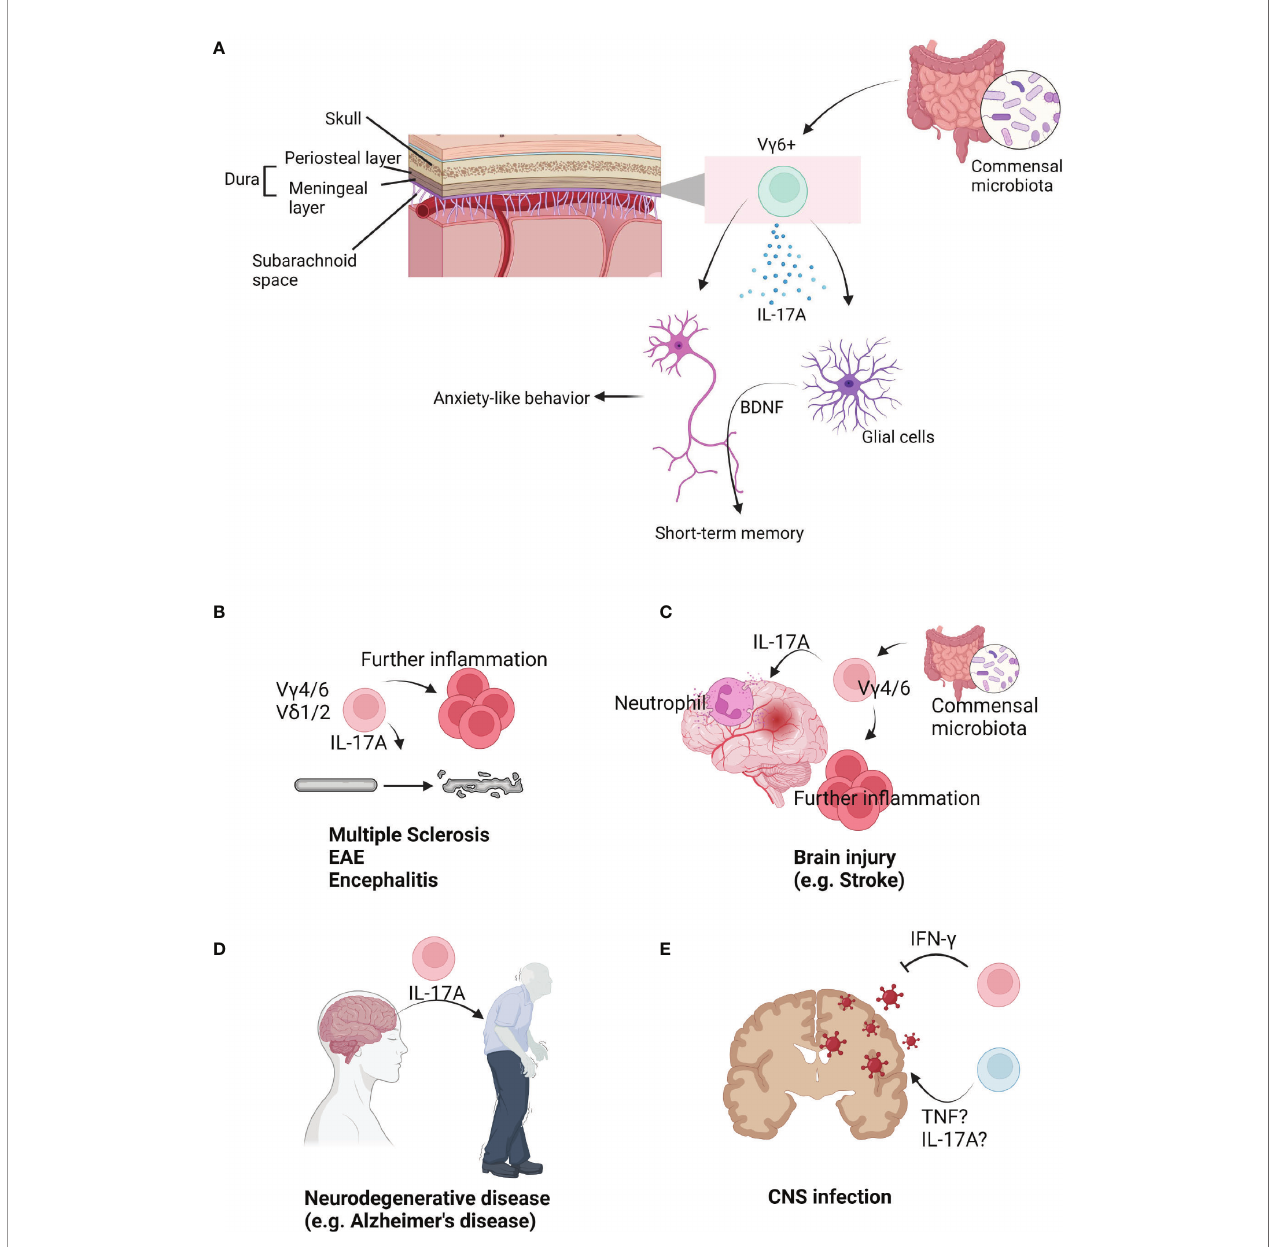
FIGURE 2 | The role of gd T cells in brain immunology. (A) Upon brain parenchyma, multiple layers surround brain. Under skull, dura mater (periosteal layer, meningeal layer) is situated. Under meningeal layer, arachnoid and subarachnoid space exist. In the meninges, V g 6+ cells are populated. They seem to be affected by commensal microbiota. Under steady state, V g 6+ cells produce IL-17A. IL-17A from meninges can be delivered into the parenchyma. Direct signal from IL-17A into neurons can regulate anxiety-like behavior. On the other hand, IL-17A can regulate short-term memory via glial BDNF. (B) gd T cells are related to progression and severity of brain autoimmune diseases. Mouse V g 4/6+ cells or human V d 1/2+ cells are known to be related to these diseases. Usually, IL-17A from gd T cells initiate or further promote diseases. (C) gd T cells are involved in injury-induced in fl ammation in the brain. V g 4/6+ cells usually produce IL-17A which recruits neutrophils. They are known to be regulated by commensal microbiota. As an early inducer, gd T cells further promote in fl ammations. (D) gd T cells are also related to neurodegenerative diseases. IL-17A may be strongly associated with development of diseases such as Alzheimer ’ s disease. (E) gd T cells can in fi ltrate into the infected brains. Multiple pathogens can infect into the brain. Usually, IFN- g -producing gd T cells resolve viral infections. However, TNF or IL-17A is associated with infection-induced in fl